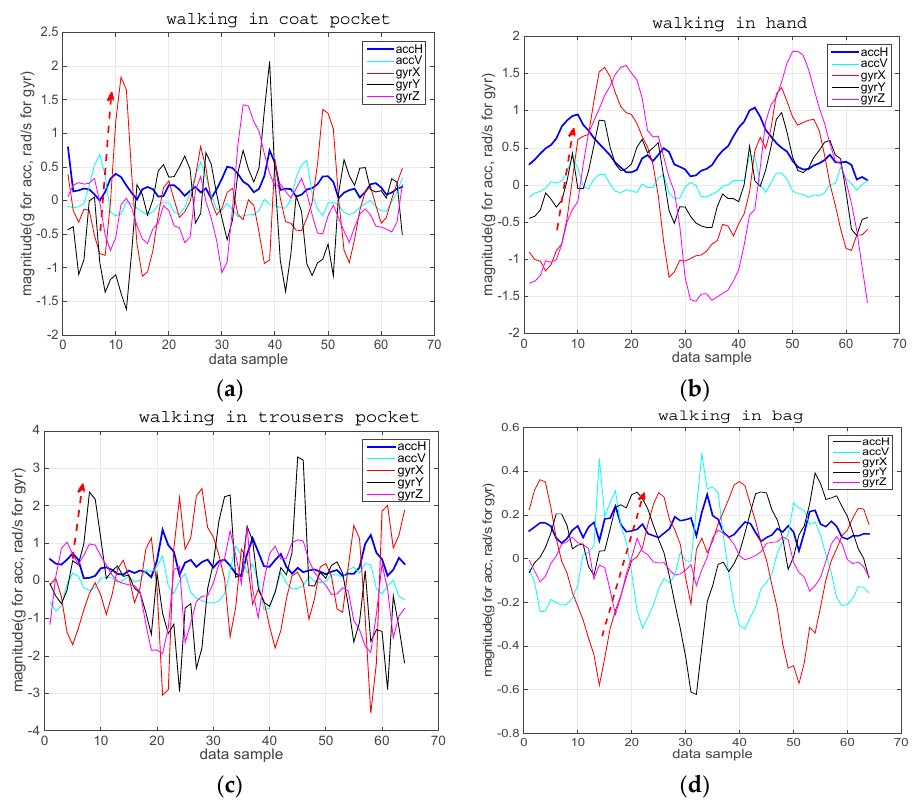
Figure 3. The waveforms of acceleration and tri-axial gyroscope for walking in four positions: ( a ) Walking—in coat pocket; ( b ) in hand; ( c ) in trouser pocket; ( d ) in bag.